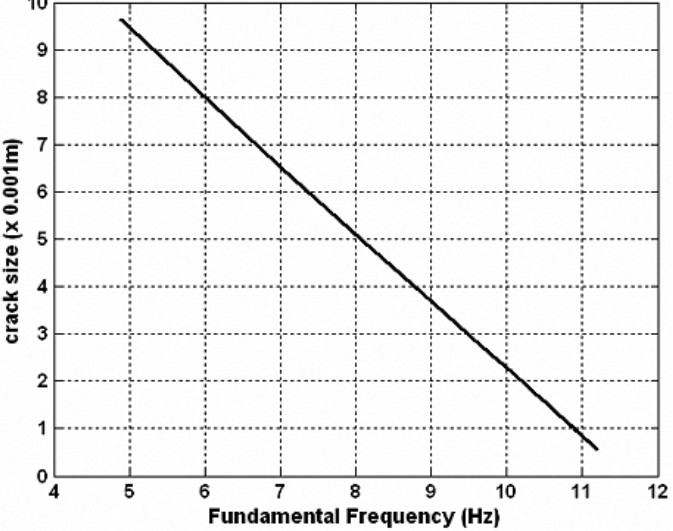
Fig. 8. Relation between fundamental frequency and crack size during degradation